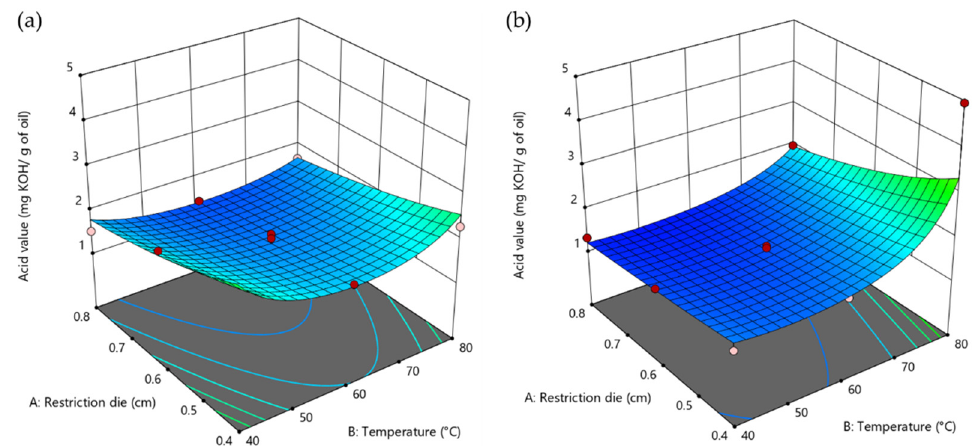
Figure 2. Response surface plot showing the effect of temperature and restriction die size on the acid value of CSO. ( a ) Sieve size: >1.4 mm, ( b ) Sieve size: <1.4 mm.